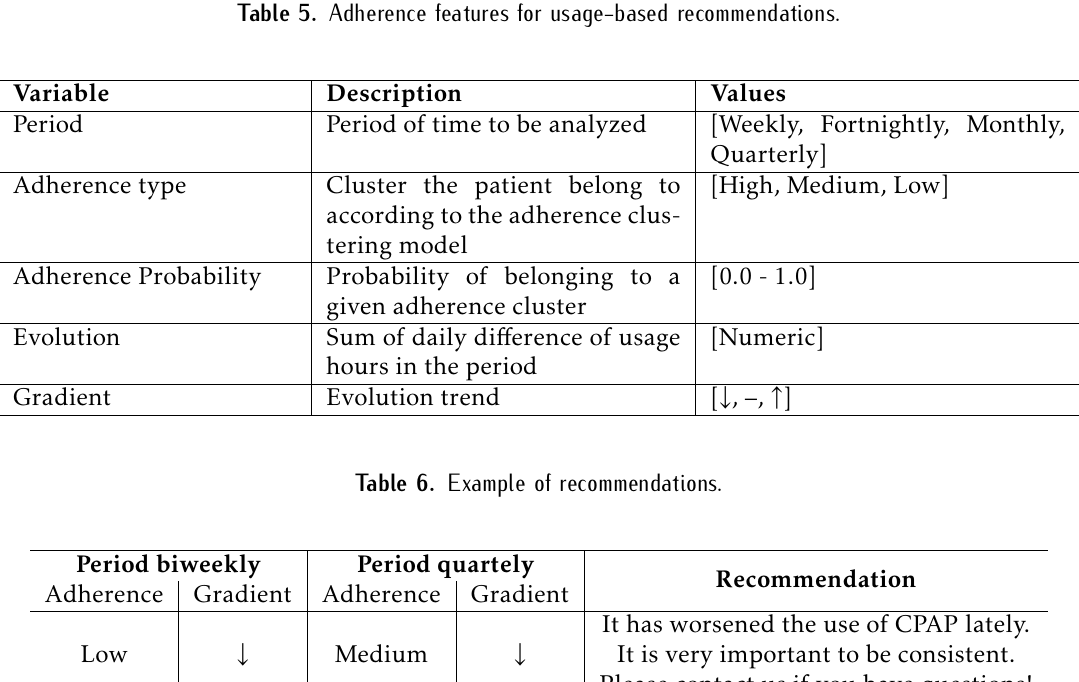
Table 5. Adherence features for usage-based recommendations.